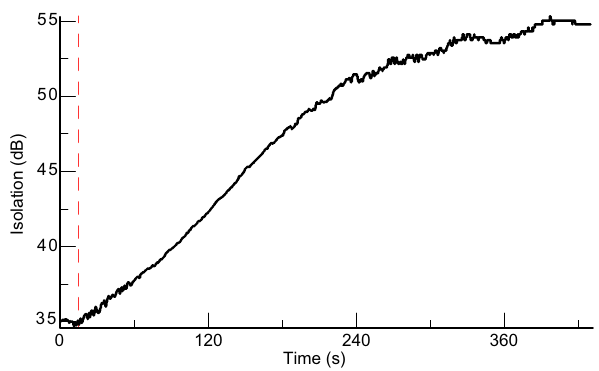
FIG. 6. Isolation of CIR 1 from port 2 to port 1 recovers gradu- ally after illumination by 3.6 W laser power. The vertical dashed line is the HPL’s switch-off